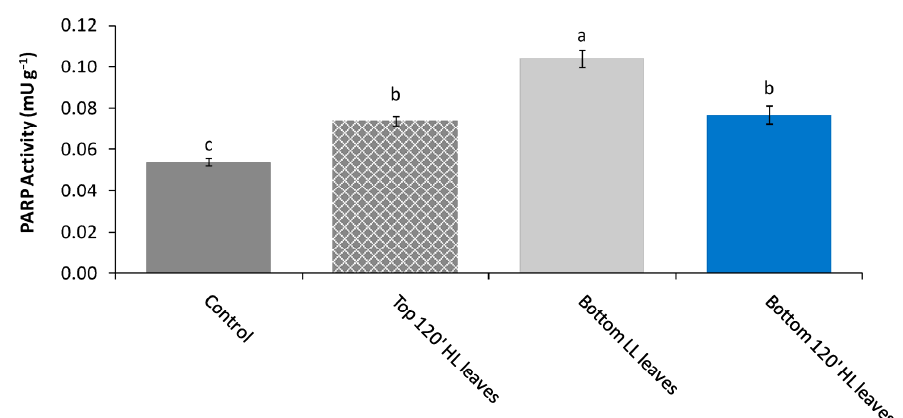
Figure 1. PARP activity in P. vulgaris L. Control, Top120’ HL leaves (inducing top leaves after 120 min of light stress), Bottom LL leaves (receiving bottom unstressed leaves) and Bottom 120’ HL leaves (receiving bottom leaves after 120 min of light stress). Different letters indicate statistically significant differences among treatments ( p ≤ 0.05) by One-Way ANOVA followed by Holm–Sidak post-hoc test (n = 5).